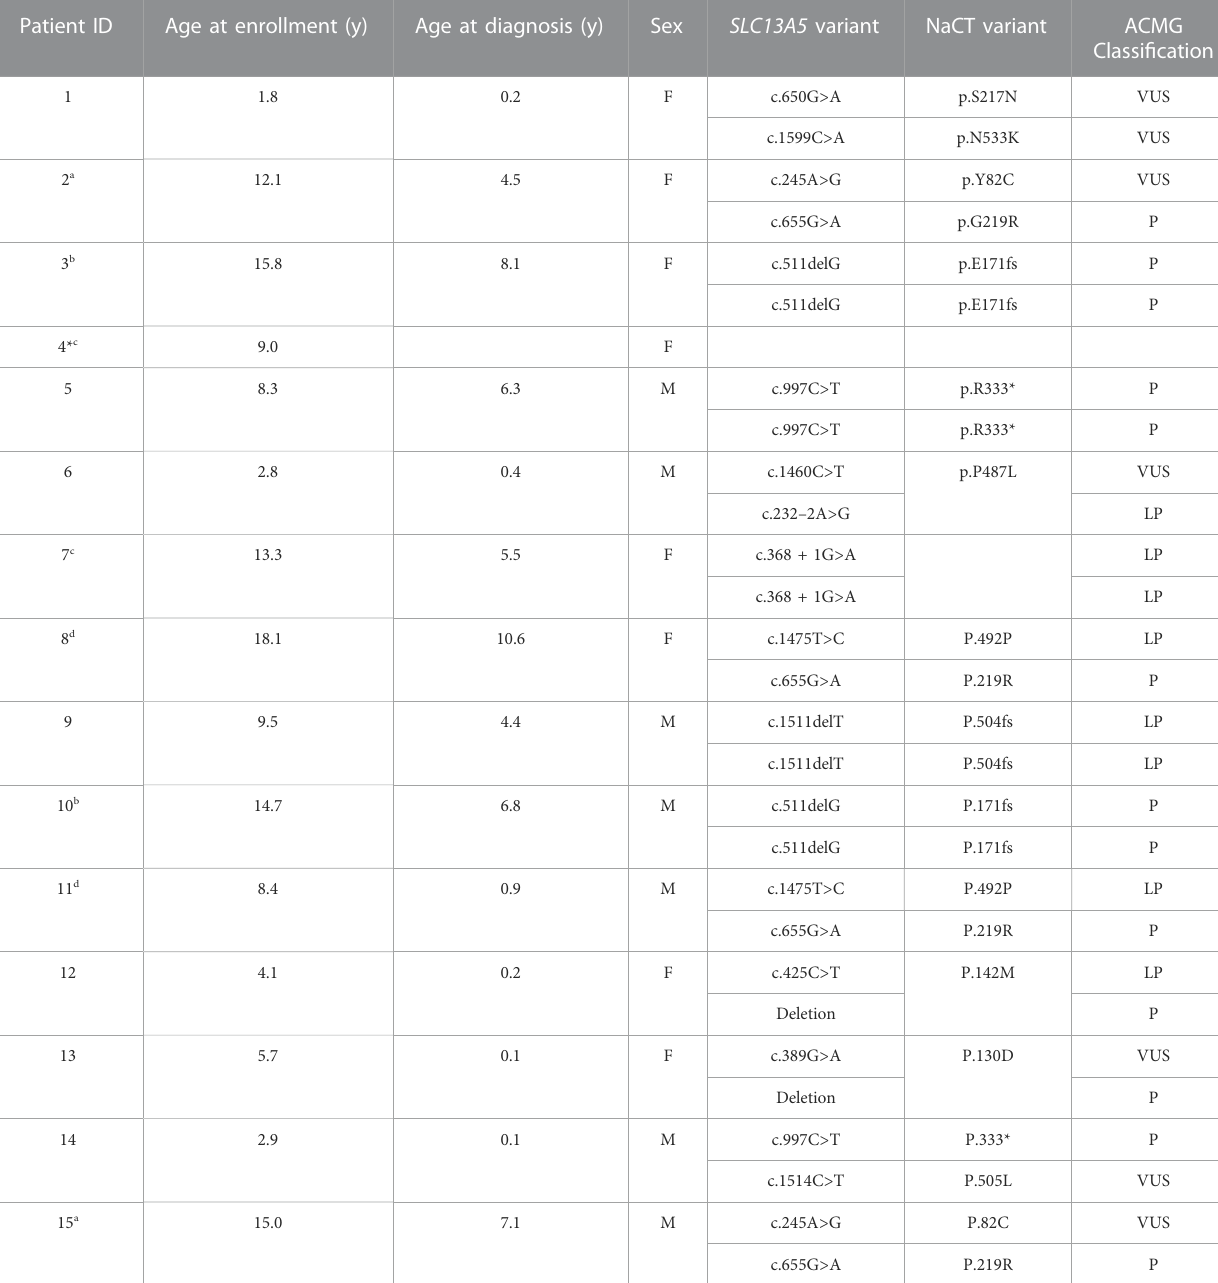
TABLE 1 Patient demographics. SLC13A5 citrate transporter disorder patients included in this assessment are listed by Patient ID, age at the time of publication, age at diagnosis, sex, SLC13A5 variant, and current ACMG classi fi cation. Variants were assessed by a certi fi ed genetic counselor; NM_177550.5 NP808218.1 Patient